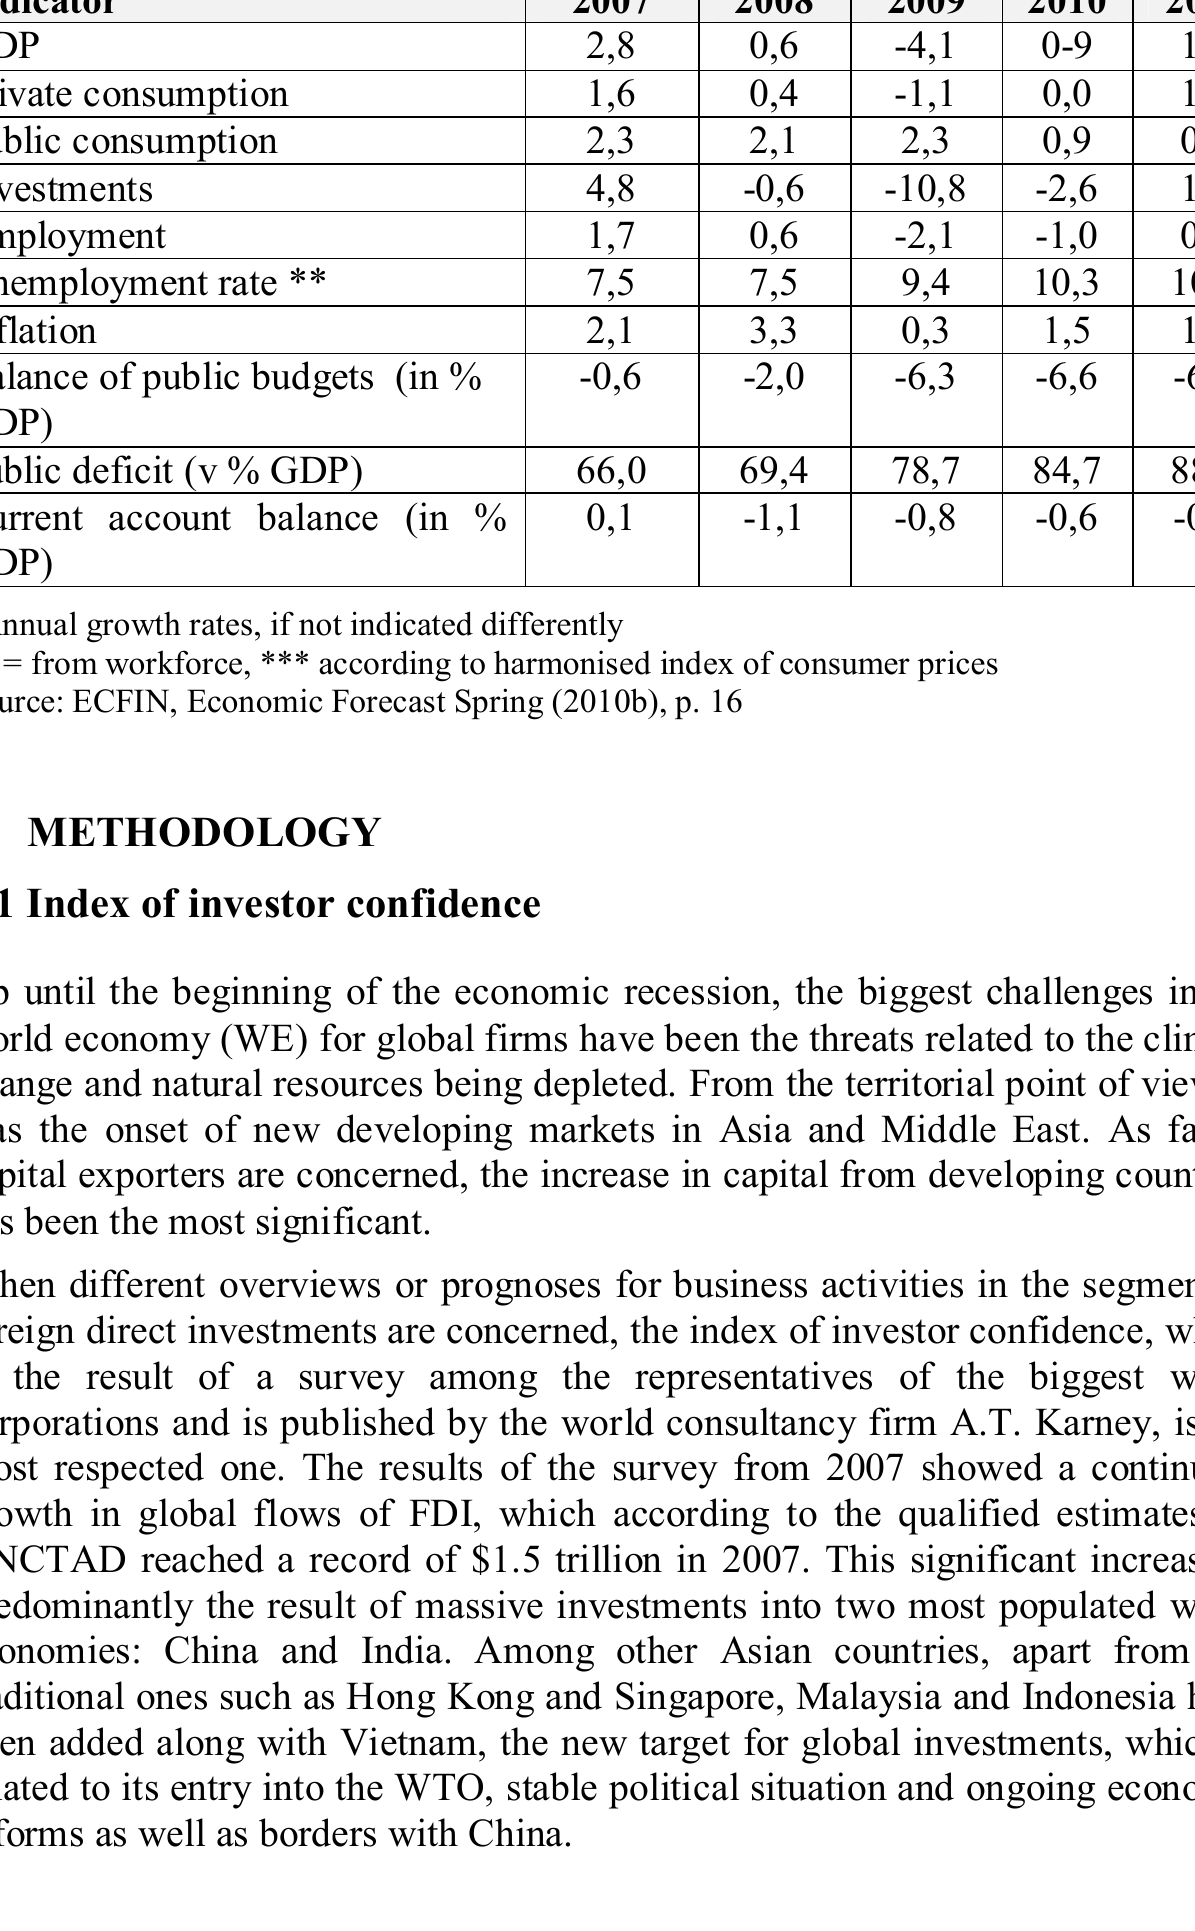
Table 2 – Selected indicators of economic development in the Eurozone in 2007- 2011*